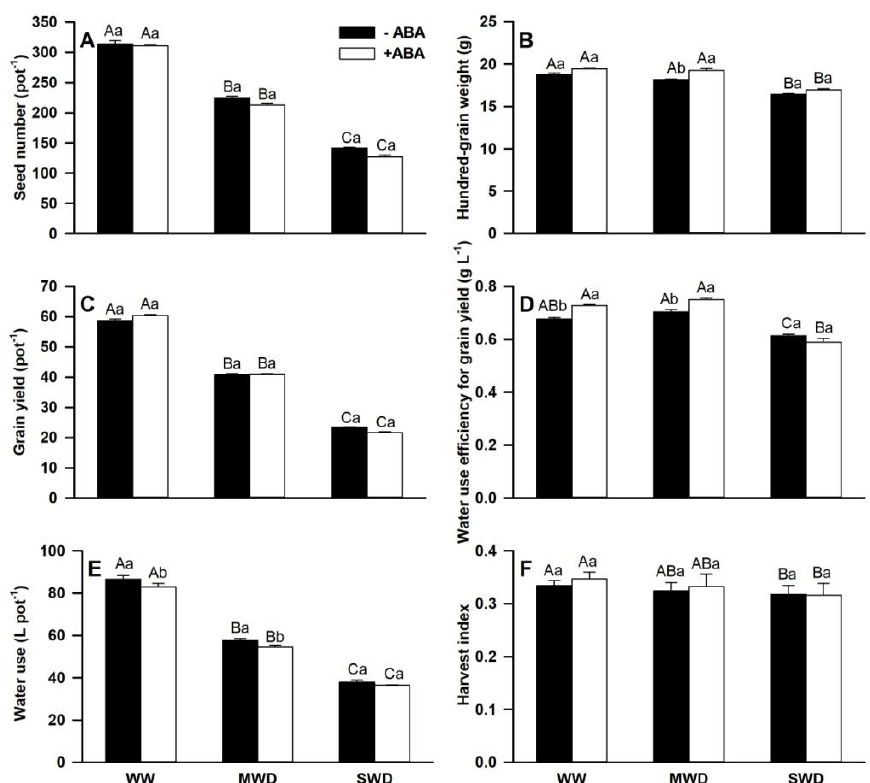
Figure 9. ( A ) Seed number (pot − 1 ), ( B ) hundred-grain weight (g), ( C ) grain yield (pot − 1 ), ( D ) water use e ffi ciency for grain yield (g L − 1 ), ( E ) water use (L pot − 1 ) and ( F ) harvest index in the soybean cultivar Jindou 19 (JD)—with and without 10 µ M exogenous ABA applied one day before withholding water—at 45 days after sowing (DAS) under three water treatments (well-watered (WW): Soil water content (SWC) maintained at 70–90% field capacity (FC); moderate water deficits (MWD): 45–55% FC and severe water deficits (SWD): 30–35% FC). Values are means ± SE ( n = 7). The capital and small letter indicated significantly di ff erent among the water treatment at the same ABA level and between the ABA treatment at the same water treatment at p = 0.05, respectively.